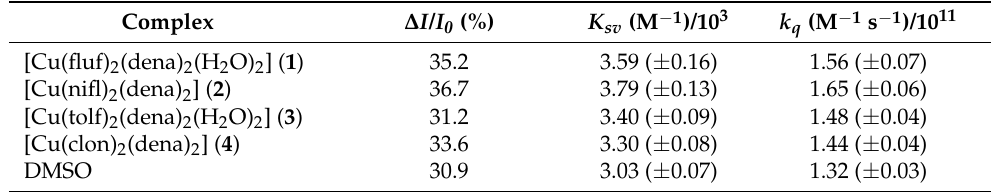
Table 7. EB-DNA fluorescence (%), calculated Stern–Volmer constant K SV and the quenching rate constant k q of DMSO and complexes 1–4 .